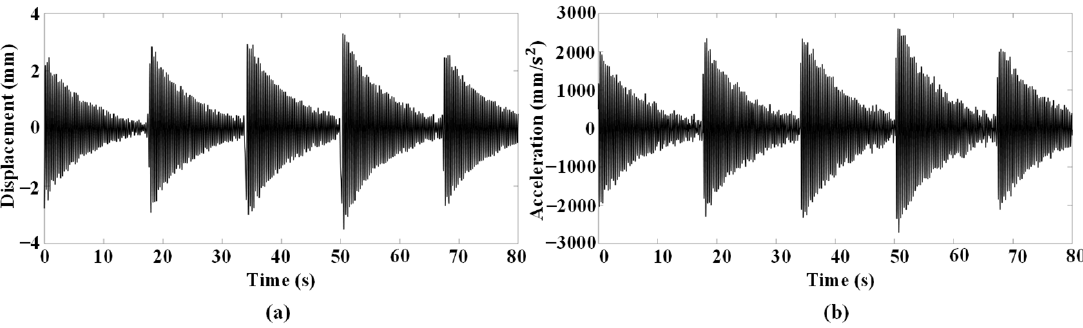
Figure 18. The signals corrected by EMD: ( a ) EMD corrected signal; ( b ) Its second-order differential.